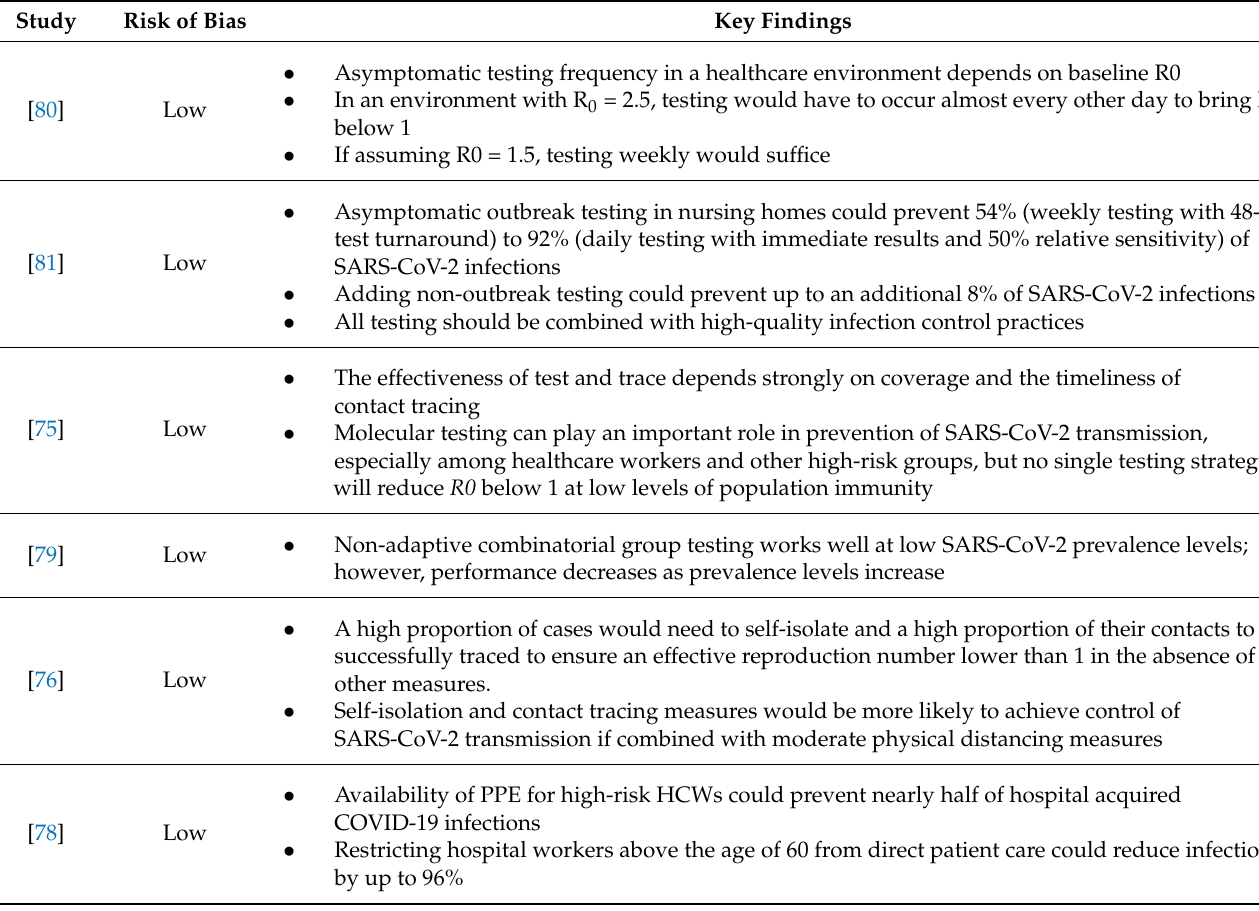
Table 9. Key findings from studies that modelled the effectiveness of workplace COVID-19 surveillance and combined IPC measures. Study Risk of Bias Key